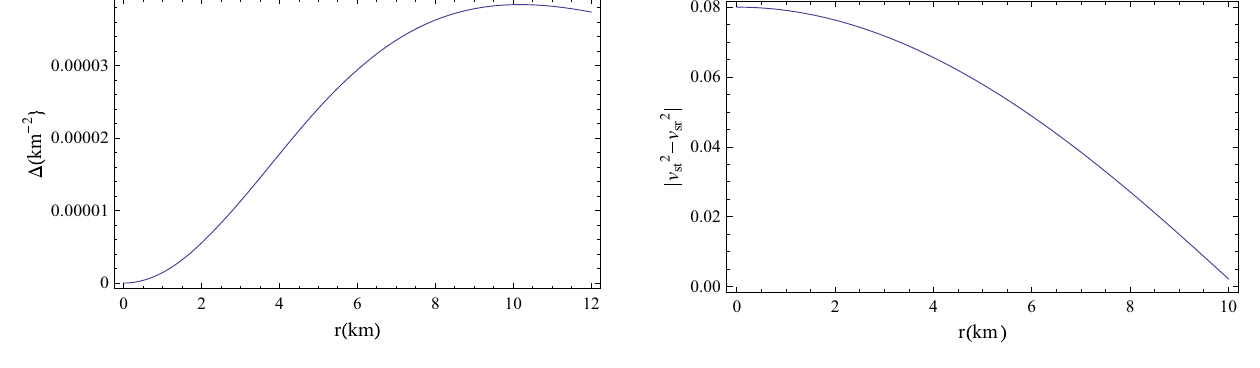
Fig. 11 Variation of | v 2 st − v 2 sr | with r of PSR J0348+0432